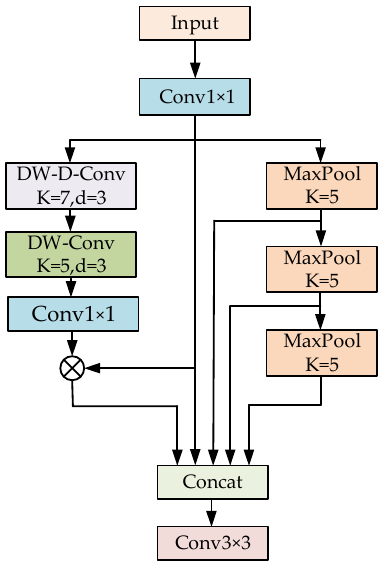
Figure 2. The structure of context enhancement module